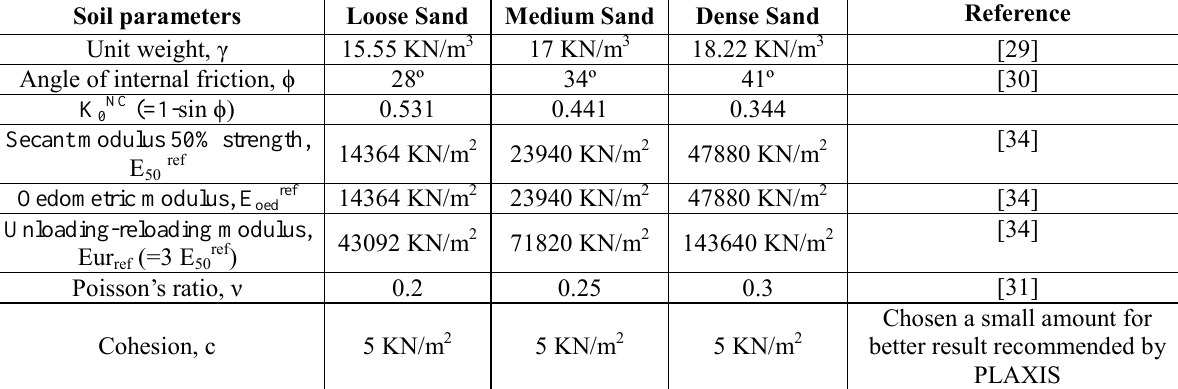
Soil parameters of different states of sand layers [Hardening Soil Model].